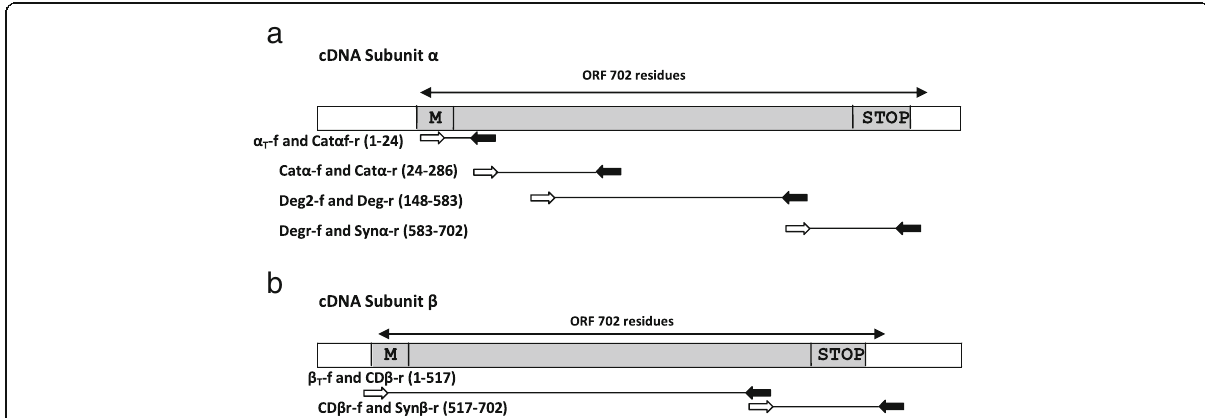
Fig. 1 Schematic cloning representation of α - and β -subunits of Sp-CTx. Forward and reverse primers are indicated by white and black arrows, respectively. The sequence of primers is shown in Table 1. Amino-acid positions are relative to the primary structures of cDNAs from Synanceia. The positions of the arrows indicate the approximate size of the putative fragment. Initiation codon (M) and stop codon (STOP). a : Union of putative fragments in α -subunit was obtained by PCRs ( α T-f and Cat α f-r, Cat α -f and Cat α -r, Deg2-f and Deg-r, Degr-f and Syn α -r). b : Union of putative fragments in β -subunit ( β T-f and CD β -r were isolated from the cDNA library and CD β r-f and Syn β -r obtained by